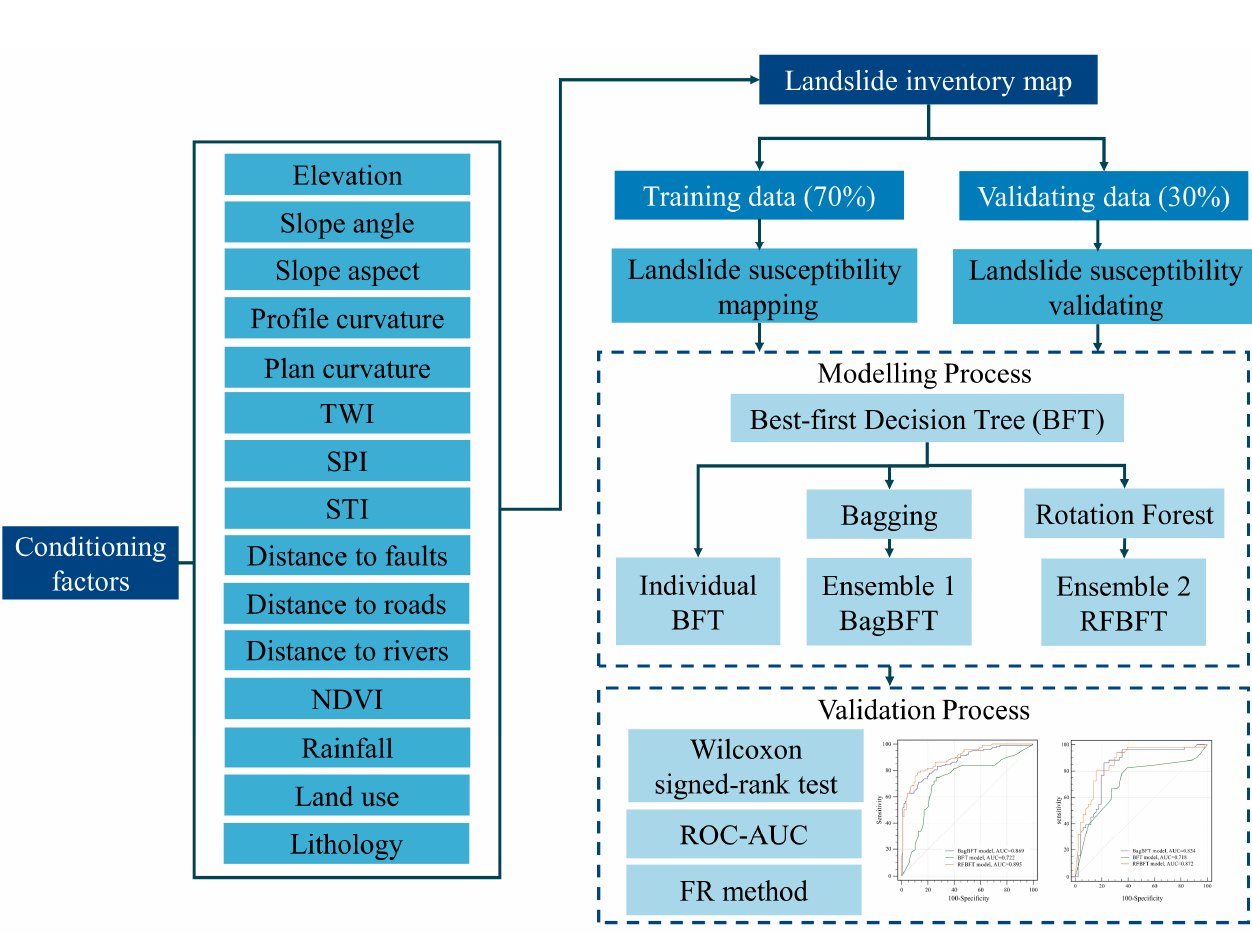
Figure 2. Flowchart of the landslide susceptibility modeling.